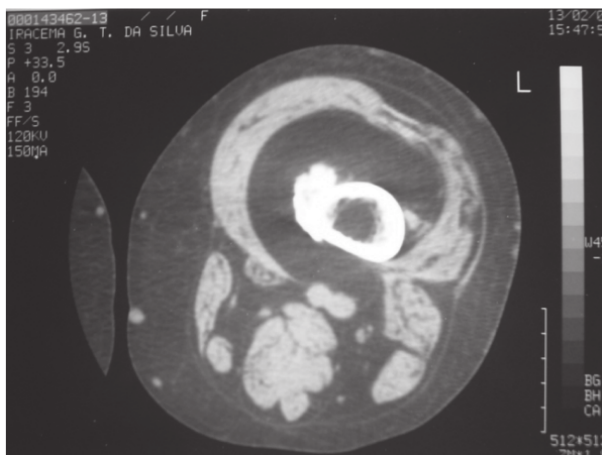
Figure 2 - Computed tomography: window of soft parts (axial view) where an intramuscular expansive process can be seen around the femur, with the radiodensity of fat. Note the hyperostosis in the cortical medial area of the bone without medullary invasion.